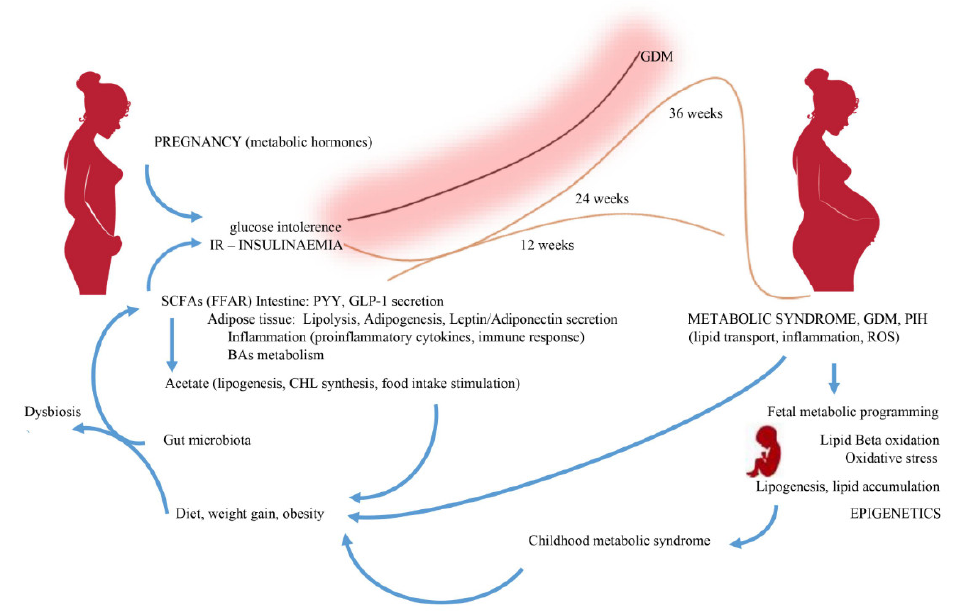
Figure 1. The influence of changing the microbiome and their metabolites on the metabolism of a pregnant woman. IR—insulin resistance; SCFAs—short-chain fatty acids; FFAR—free fatty acid recep-tor; Bas—bile acids; GDM—gestational diabetes mellitus; PIH—pregnancy induced hy-pertension; GLP-1—glucagon-like peptide-1; PYY—peptide YY; ROS—reactive oxygen species.